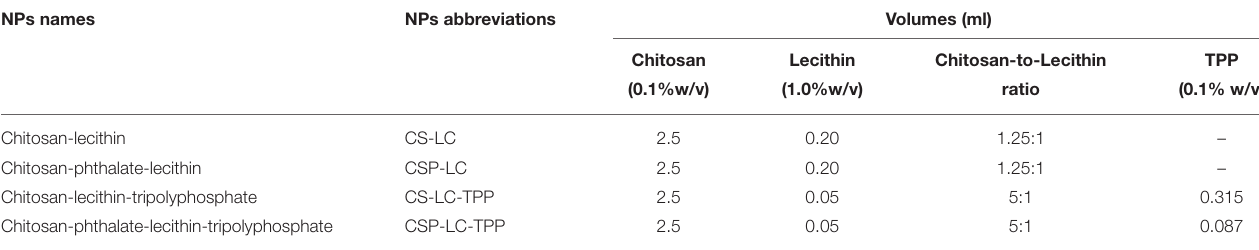
TABLE 1 | Prepared NPs, their abbreviations and corresponding amounts of components required for formulation. NPs